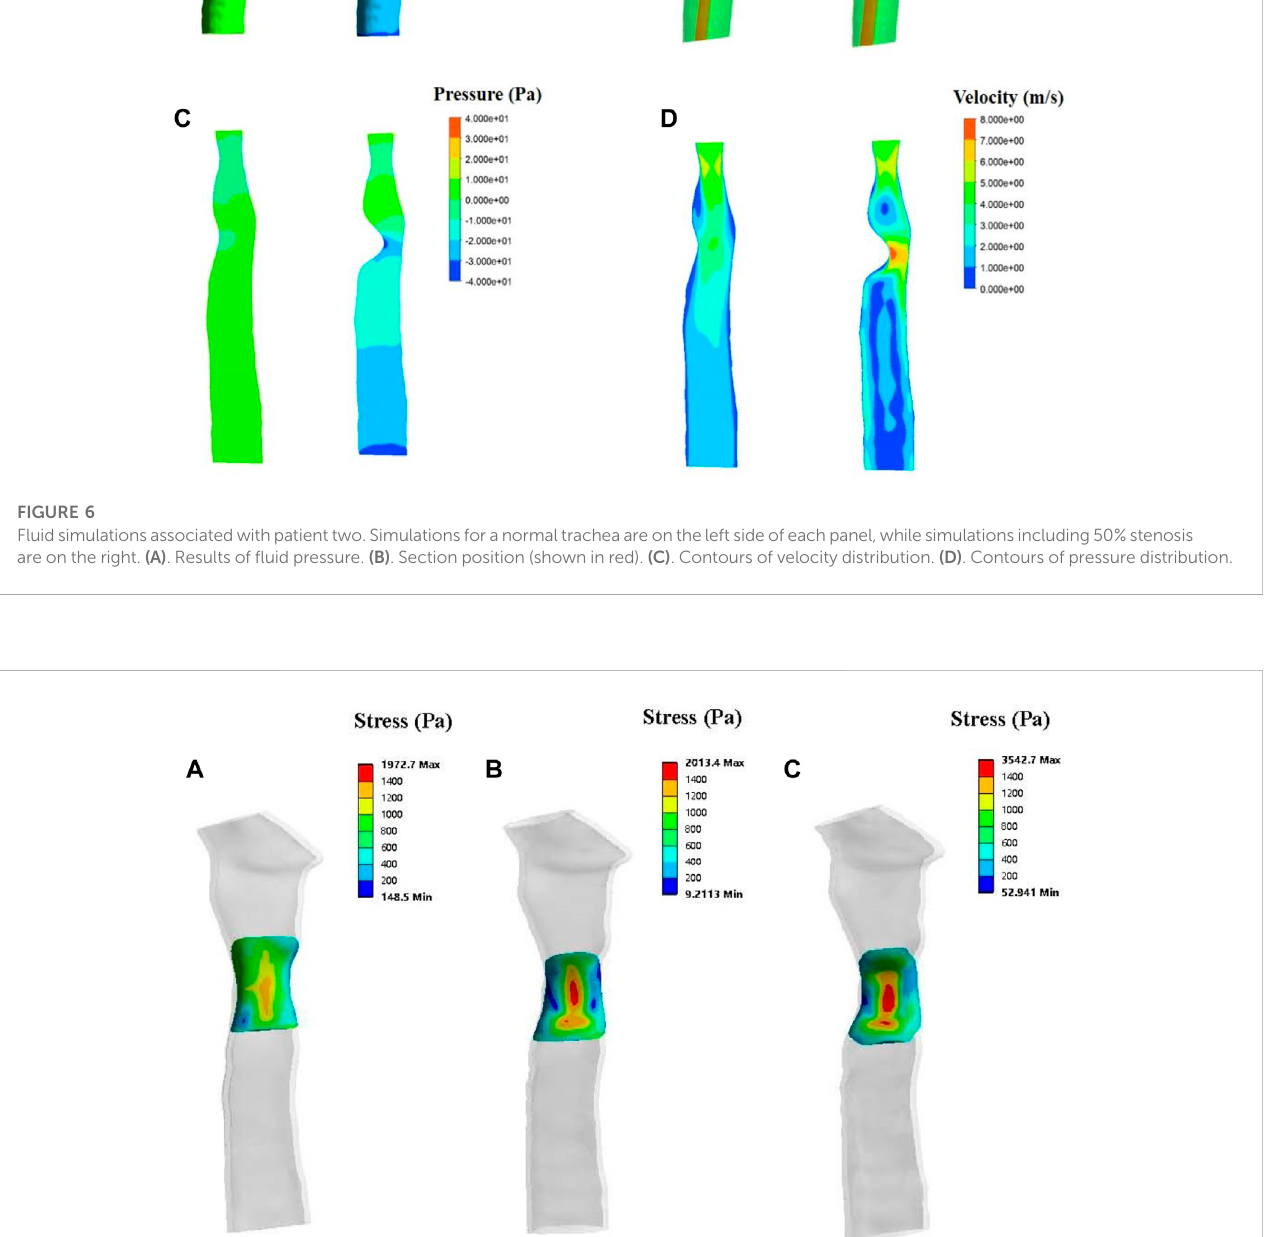
Frontiers in Bioengineering and